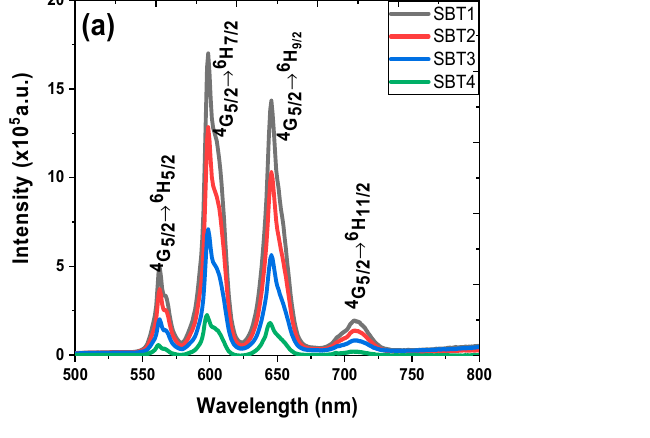
Figure 6. ( a ) Visible and ( b ) near-infrared (NIR) wavelengths photoluminescence spectra of different concentrations of Yb 3+ in Sm 3+ -doped barium fluorotellurite glass series. Figure 6a,b represent the photoluminescence spectra of the Sm 3+ -doped and Sm 3+ :Yb 3+ -codoped barium fluorotellurite glass series in the visible and near-infrared spectral ranges. The visible photoluminescence emission spectra reveal four broad and intense peaks centred at 562 nm (yellow-green band), 598 nm (orange band), 646 nm (red band), and 707 nm (red band), attributing to the 4f-4f interconfigurational transitions. These emission peaks correspond to the 4 G 5/2 → 6 H 5/2 , 4 G 5/2 → 6 H 7/2 , 4 G 5/2 → 6 H 9/2 , and 4 G 5/2 → 6 H 11/2 transition bands shown in Figure 5. Similarly, the NIR photoluminescence emission spectrum peaks of the Sm 3+ -doped glass centred at 906, 949, 1030, 1130, 1200, 1293, and 1418 nm correlating with the 4 G 5/2 state to 6 F J ( J = 3/2, 5/2, 7/2, 9/2) and the 6 F 11/2 state to 6 H J ( J = 7/2, 9/2, 11/2) transitions. It is essential to mention that this is the first